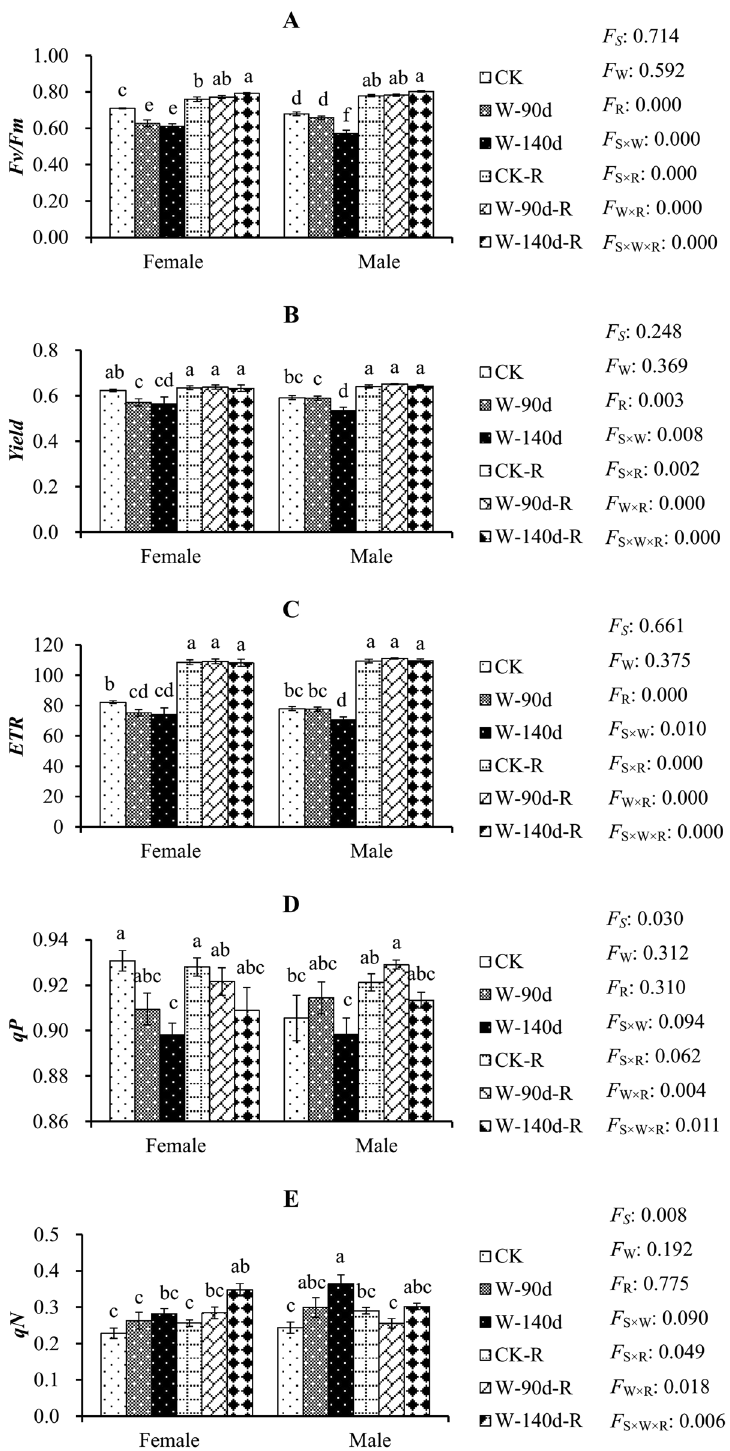
Figure 3. The relative electrolyte leakage (REL) and relative water content (RWC) variations in male and female P. deltoides under winter flooding stress and post-flooding recovery. CK, control treatment; W, flooding and waterlogging stress treatment; R, recovery after waterlogging stress. Values are means ± SE ( n = 5). Letters above the columns indicate significantly differences at P < 0.05 according to Duncan’s test. The significance values of the factorial analysis (ANOVA) for: F S , F W , and F R refer different effects of species, watering, and recovery growth, respectively;